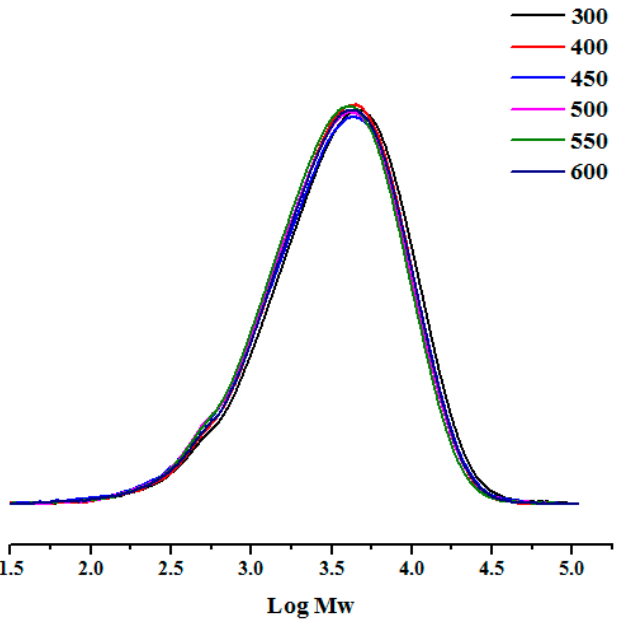
Figure 4. GPC curves of the PE produced using Ni1 /EtAlCl 2 at different Al:Ni molar ratios (runs 1–6, Table 3).